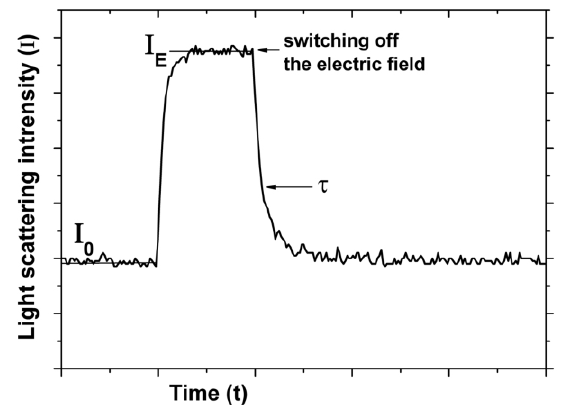
Figure 1. Electro-optical pulse: Light scattering intensity ( I ) as a function of the time ( t ).